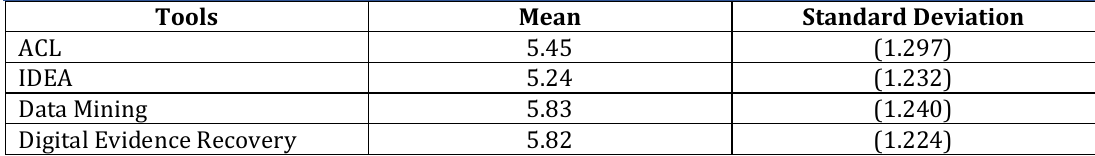
Table 18: Response about the Ratings of the Importance of the Software Tools for